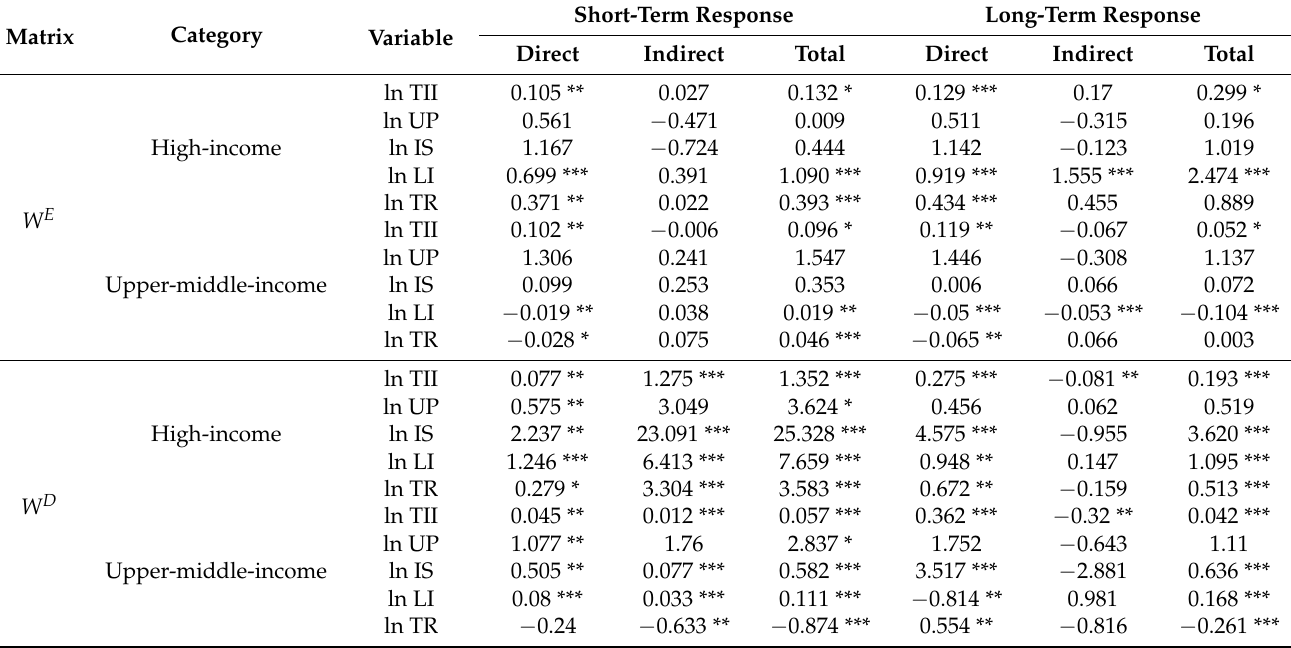
Table 8. Estimation results of direct, indirect, and total